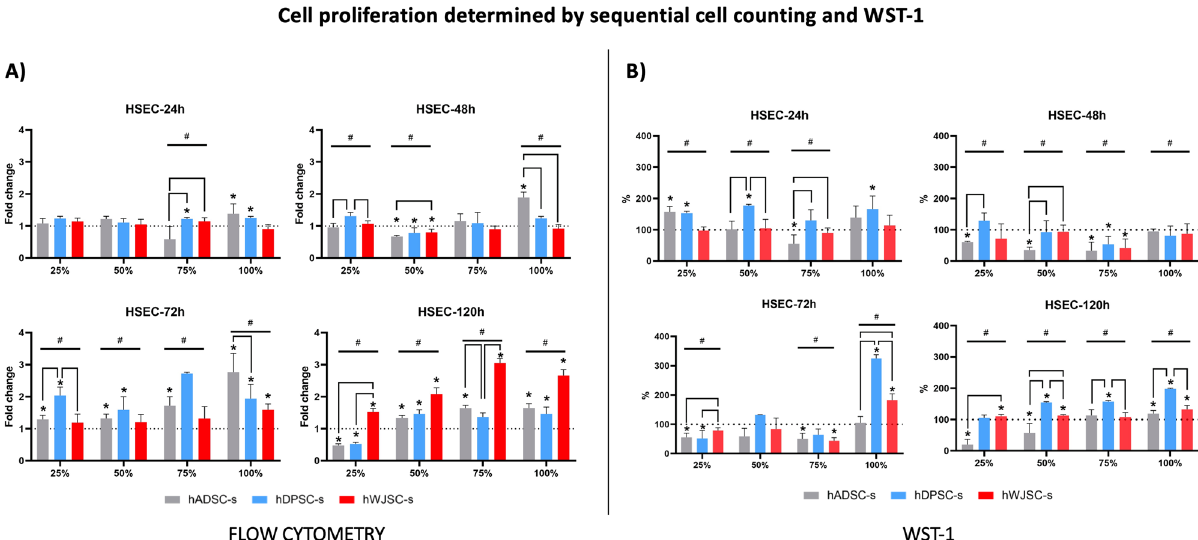
Figure 4. Analysis of cell proliferation determined by sequential cell counting and WST-1 analysis in HSEC exposed to different types (hADSC-s, hDPSC-s and hWJSC-s) and concentrations (25%, 50%, 75%, 100%) of secretome after 24, 48, 72 and 120 h of follow-up. ( A ) Cell counts were determined by flow cytometry. Results are shown as fold-change (FC) number relative to controls (considered FC = 1). ( B ) WST-1 activity. Results are shown as the percentage of metabolic activity after normalization with respect to controls (considered 100%). In both cases, error bars correspond to standard deviations. Statistically significant differences with controls are labeled with asterisks (*), whereas comparisons between types of secretome are grouped with a horizontal square bracket. Statistically significant differences detected with the Kruskal–Wallis test are labeled with